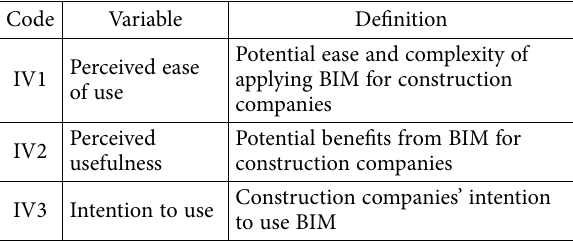
Table 4. Internal variables in the BIM TAM-TOE model